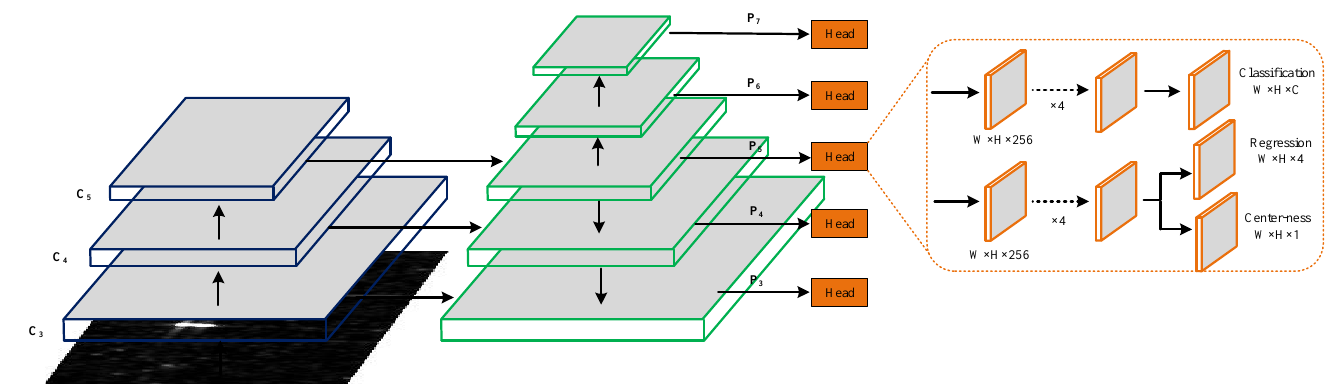
Figure 2. The predicted 4D vector of FCOS.